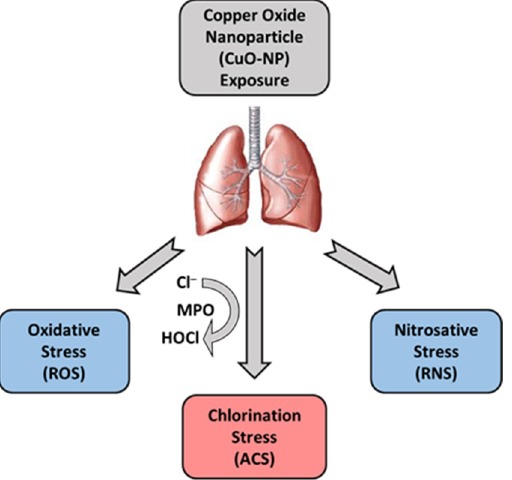
Figure 11. Schematic presentation of CuO-NP-induced lung inflammation and injury. CuO-NPs induce, in addition to nitrosative and oxidative stress in lung tissues, chlorination damage by the action of ACS generated by recruited PMN and macrophages.